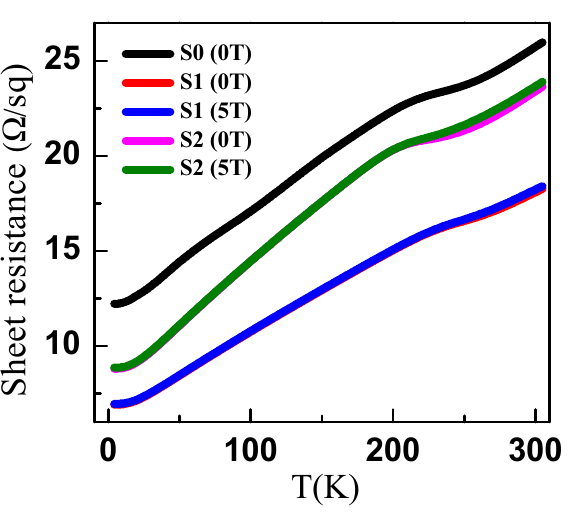
0, 5 T showing the metallic behaviour of S0–S2 =